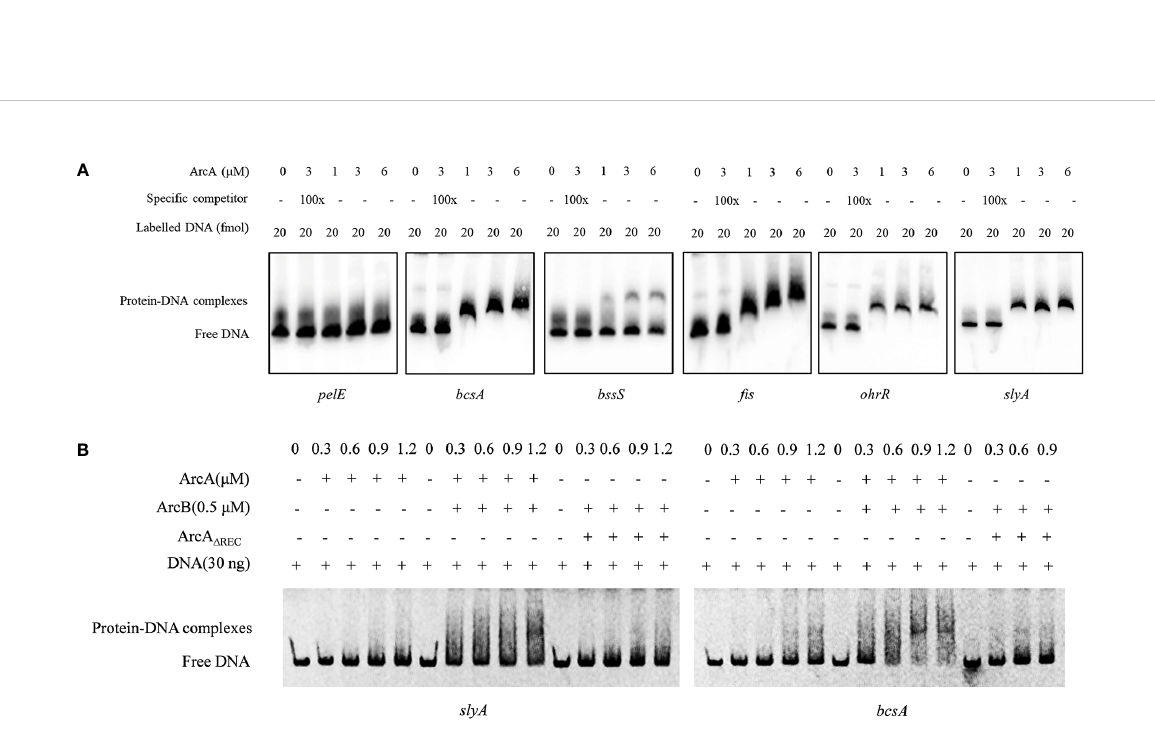
FIGURE 8 Interaction of ArcA with target genes. (A) Labeled DNA sequences of 20 fmol corresponding promoters of pelE , bcsA , zmsA , bssS , fi s , slyA and ohrR were incubated with 1 m M, 3 m M, and 6 m M ArcA protein, respectively. About 100-fold higher amount of unlabeled corresponding promoter DNAs were used as speci fi c competitors. The positions of protein-DNA complexes and free DNA probes were shown. (B) Binding ability of ArcA with target probes is enhanced by addition of ArcB and reduced after deletion of the REC domain. The experiment was performed at least twice with similar results.